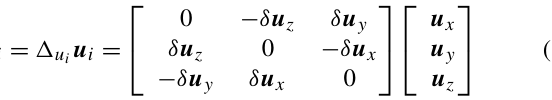
errors from the engaged gears and assembly error. However, repetitive experiments had indicated the axial error of lead screw assembled weighted majority among the translation er- rors, therefore, the transmission errors are not included in the mechanism accuracy model. The output errors δb i,x , δb i,y and δb i,z refer to inaccuracy between the end of each lead screw and nominal contact center on a side of the